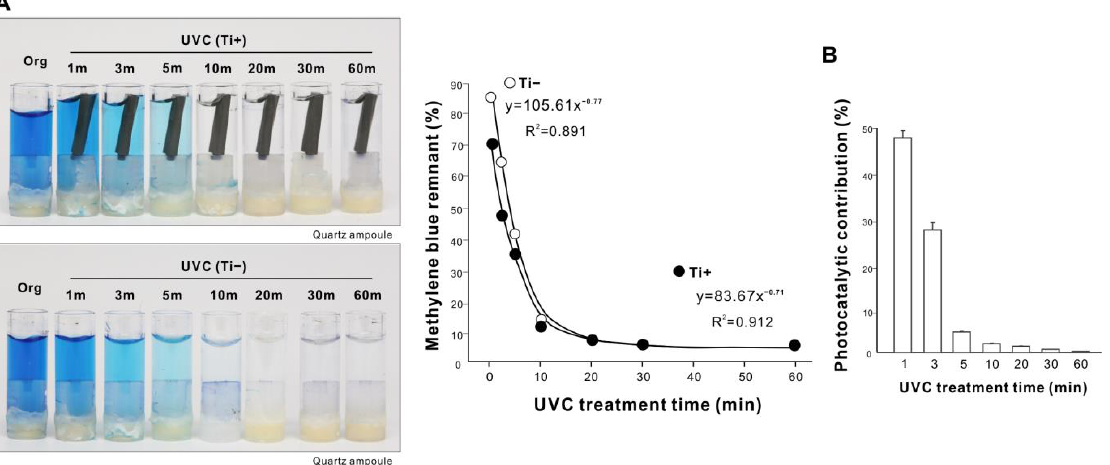
Figure 5. Dose dependency of UVC organic decomposition. ( A ) Photographs of the original methylene blue solution in a quartz ampoule together with solutions after UVC treatment for various treatment times from 1 to 60 min. The remaining methylene blue was quantified and plotted against UV treatment time; it showed a highly fitted, negative exponential curve. ( B ) Photocatalytic contribution (%) calculated as the difference in the amount of decomposed methylene blue with and without a microroughened titanium specimen.